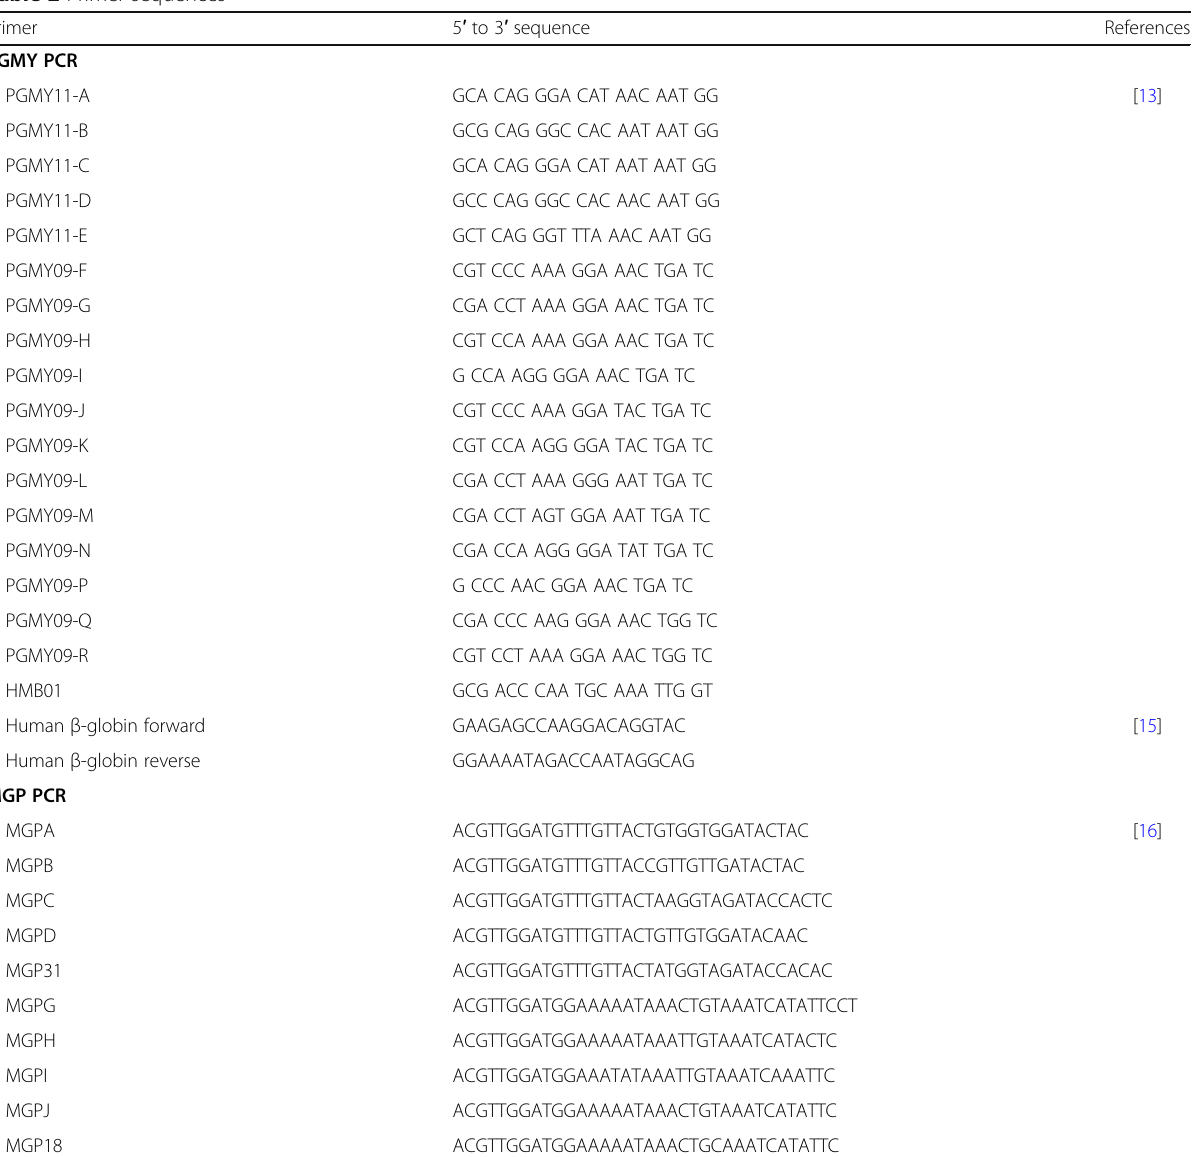
Table 2 Primer sequences Primer 5 ′ to 3 ′